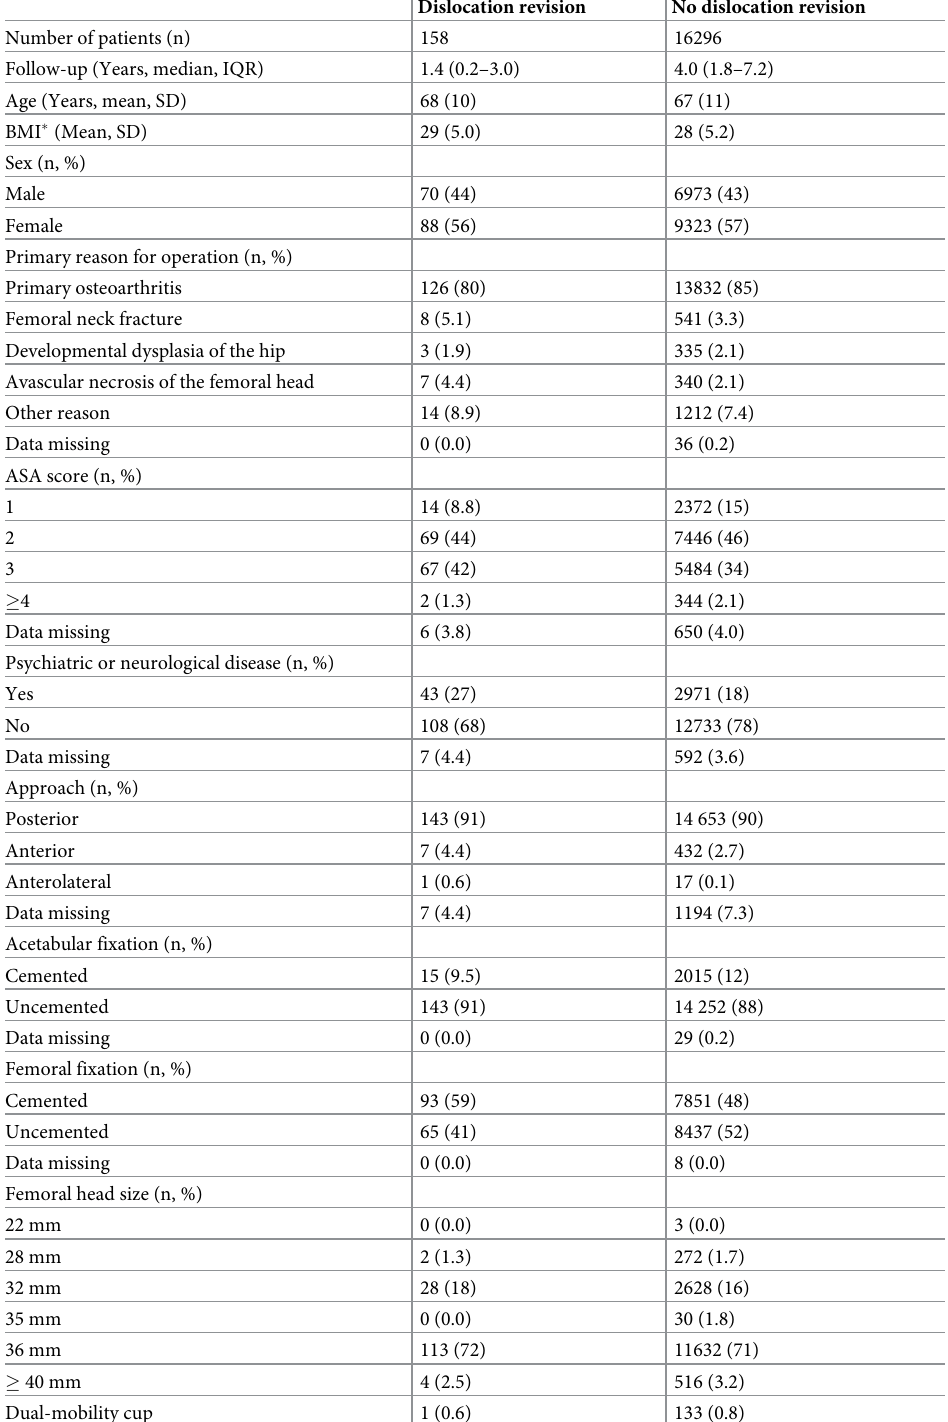
Table 1. Patient